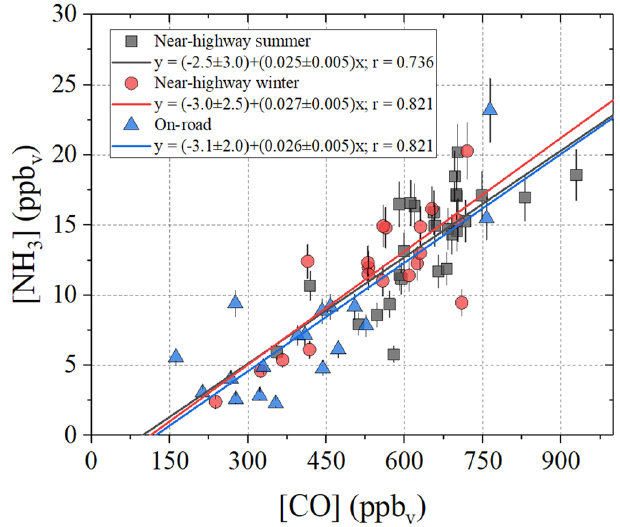
Figure 3. Linear relations between [ NH 3 ] and [CO] from the near- highway (Providence, RI, USA) and mobile on-road (northeast- ern USA) measurements. The [ NH 3 ] data were based on acid- coated denuder collection, and the [CO] represents the average of the online-determined concentrations over the collection period. The linear regressions (solid lines) and Pearson’s correlation coeffi- cients ( r ) are provided for each respective measurement